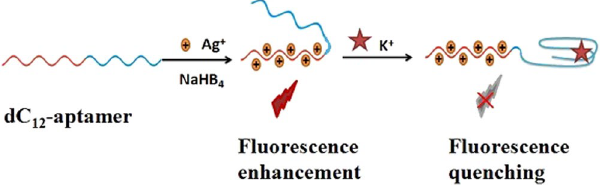
Figure 1. Schematic illustration of the DNA-AgNCs based fluorescence aptasensor assay of K +